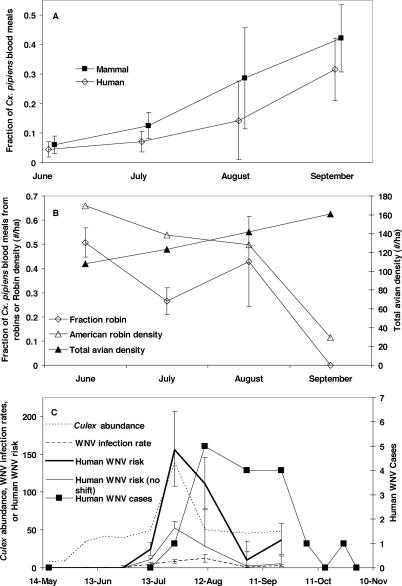
Cx. pipiens Feeding Patterns, Avian Population Dynamics, and West Nile Virus Epidemiology(A) Fraction of 148
Cx. pipiens blood meals (±1 SE) from humans and mammals (including humans) identified by PCR and DNA sequencing.
(B) Density (birds per hectare) of American robins, density of all birds, and the fraction (±1 SE) of mosquito feedings on robins.(C) Abundance of
Culex mosquitoes per trap-night,
Culex WNV infection rate (1,000 * infection prevalence, ±1 SE), estimated human WNV infection risk (±1 SE), calculated as the product of mosquito abundance, WNV infection rate, and the time-varying probability of feeding on humans (Human risk) or the June probability, 0.04 (Human risk – no shift), and the number of human WNV cases in Maryland in 2004.